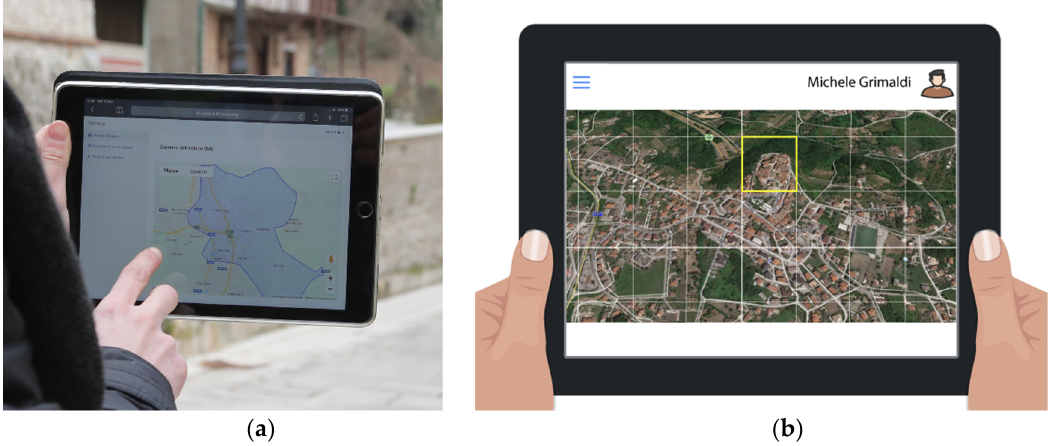
Figure 23. ( a ) An onsite responder and ( b ) the zone associated to him.